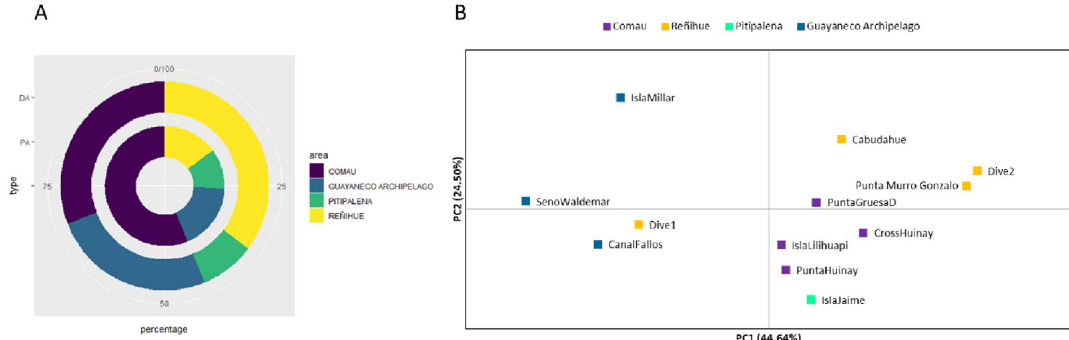
Figure 2. Nested donut plot on genetic beta diversity indicating percentage of PA (Private Allele, internal doughnut) and DA (Different Alleles, external doughnut) of each area ( A ). Principal Coordinates Analysis (PCoA) plot of genetic distance (based on the F ST value) among localities ( B